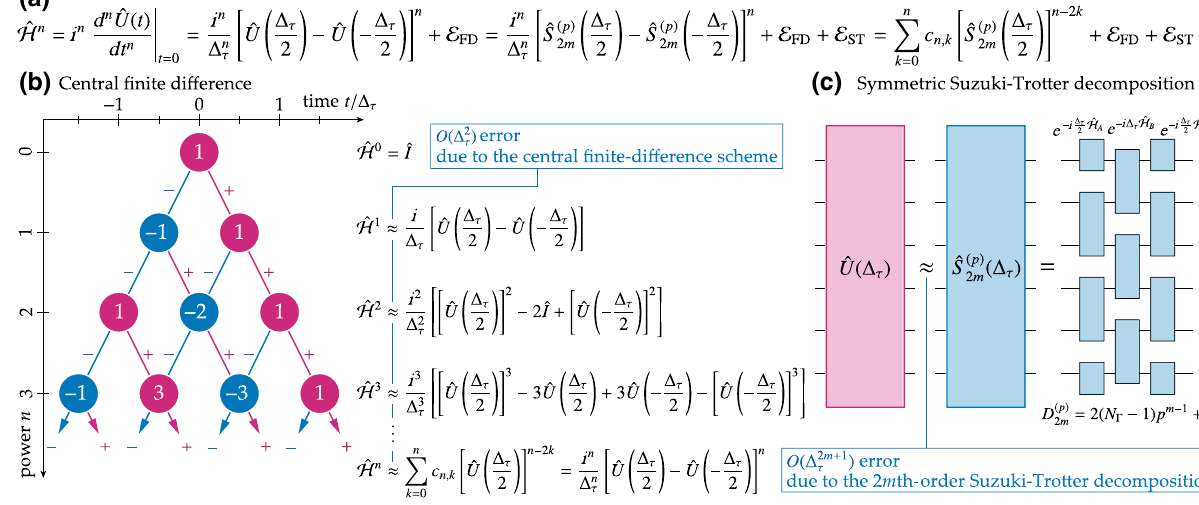
ˆ H n is approximated as a linear combina- ˆ ( p ) ((cid:3) / 2 ) S τ 2 m